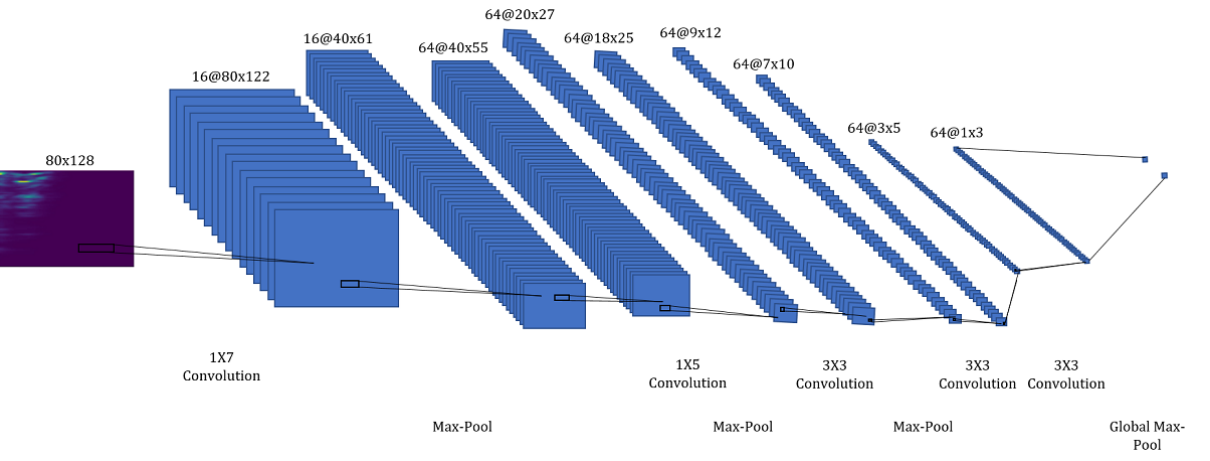
Figure 1. The architecture consists of 5 convolutional layers with alternating max-pooling layers followed by a global max-pooling layer. The annotation "16@80x122" refers to a feature map with dimensions (height x width) and 16 channels. The annotation "1x7 Convolution" refers to a convolutional filter with spatial dimensions (height x